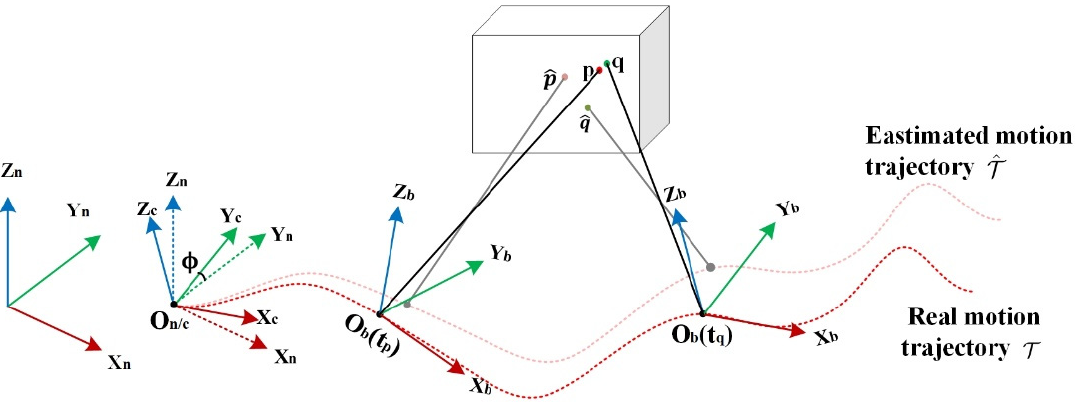
Figure 2. Inertial-aided mobile LiDAR scanning point cloud registration method.